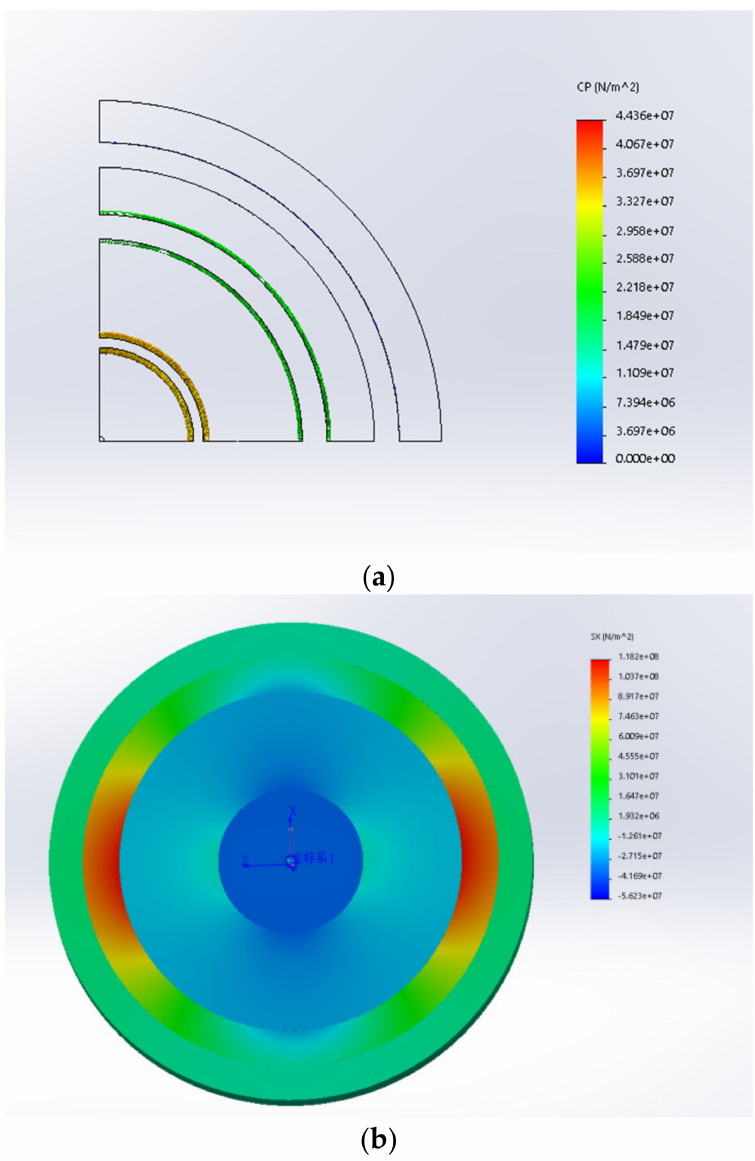
Figure 13. ( a ) Contact pressure diagram. ( b ) X-axis orthogonal stress